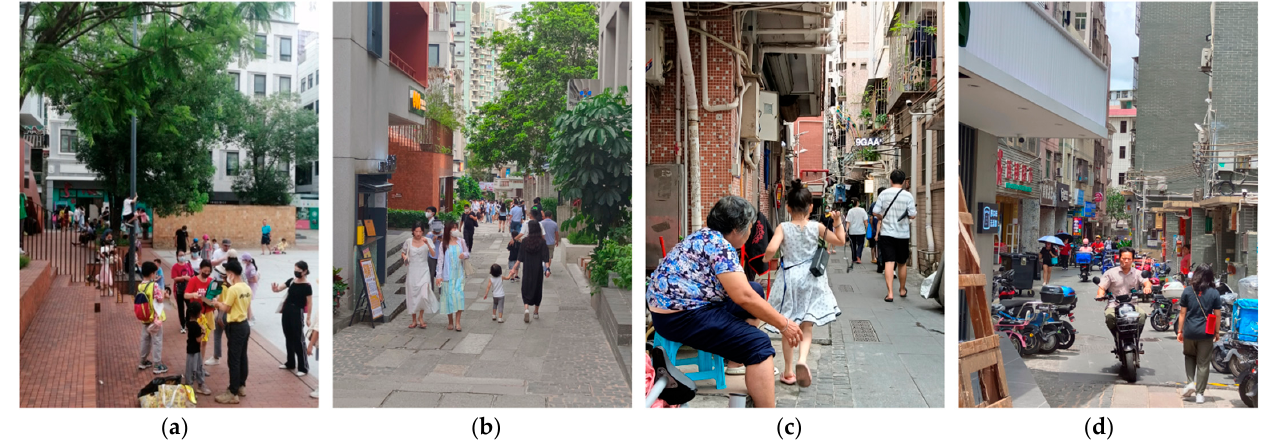
Figure 4. Nantou Old Town: ( a ) Regenerated area: Baode Square; ( b ) Generated area: Zhongshan South Street; ( c ) Unregenerated area; ( d ) Unregenerated area.